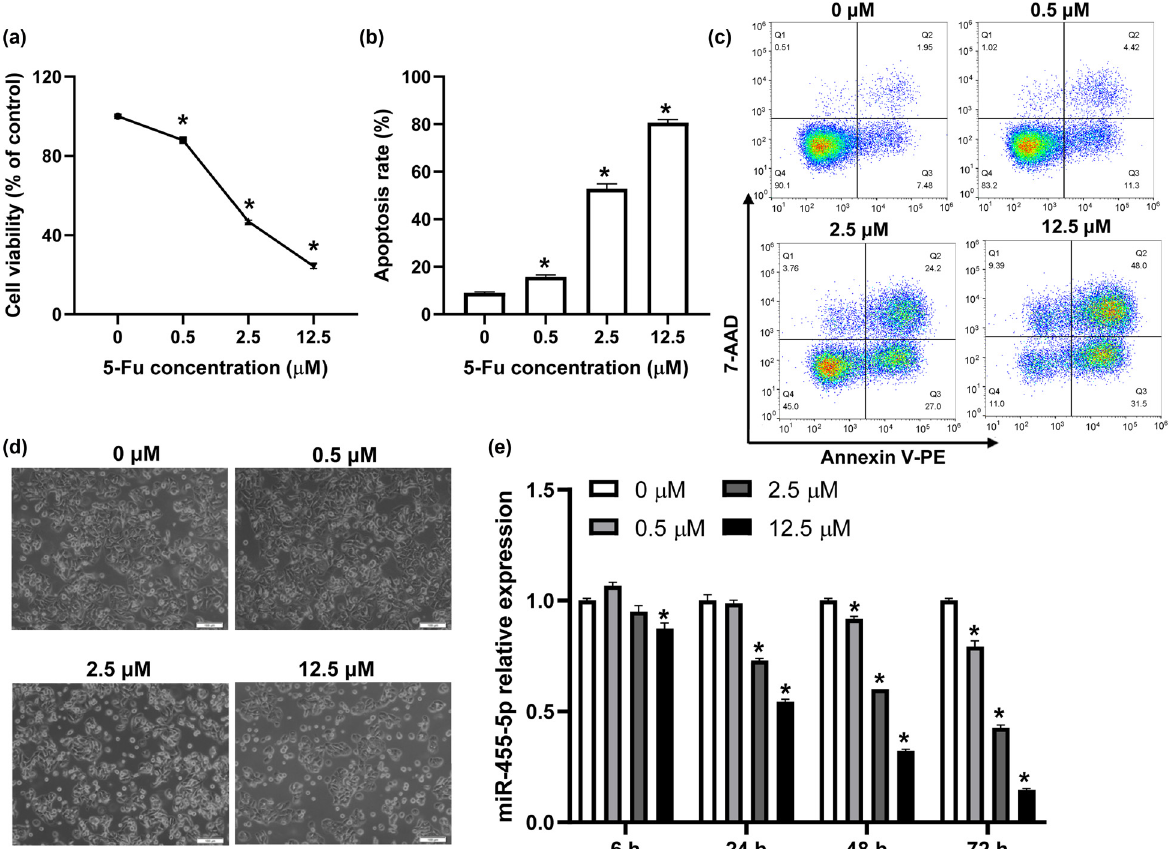
Figure 1: miR - 455 - 5p expression decreased in 5 - Fu - treated CRC cells. ( a ) HT - 29 cells were treated with di ff erent concentrations of 5 - Fu for 48 h, CCK - 8 was used to assay cell viability. ( b and c ) Flow cytometry was used to detect the apoptosis of HT - 29 cells under di ff erent treatments. ( d ) Cell morphology was observed with a microscope. ( e ) The expression of miR - 455 - 5p was analyzed by real - time PCR in HT - 29 cells after treatment with 5 - Fu ( 0, 0.5, 2.5, and 12.5 μ M ) for 6, 24, 48, and 72 h. * P < 0.05 vs the control ( 0 μ M )